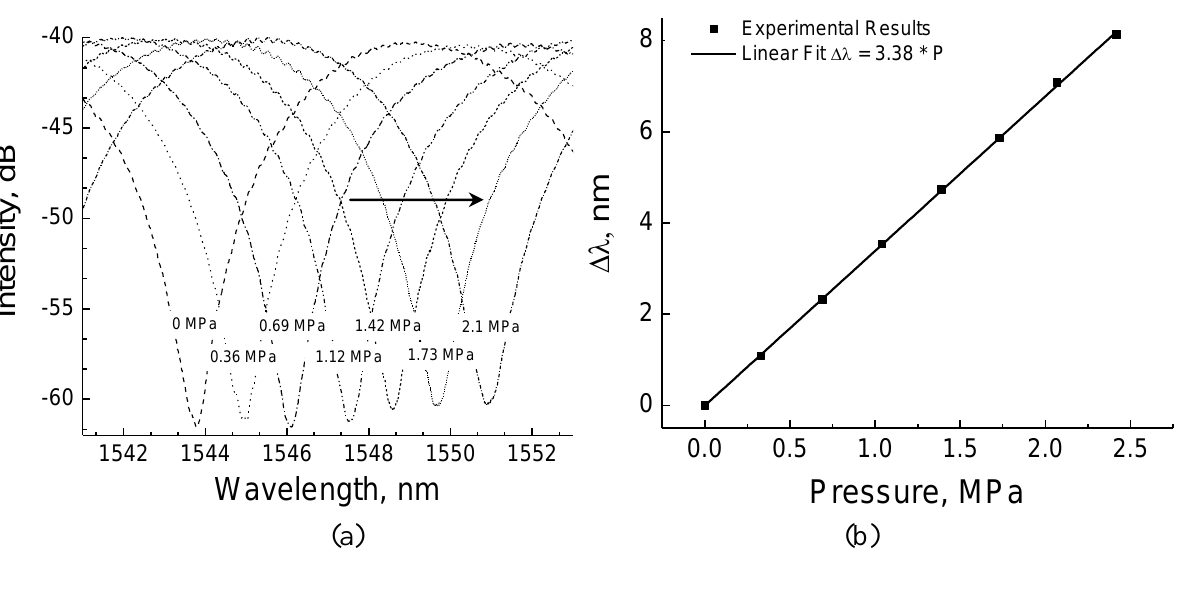
Figure 7. Temperature response (λ = 1,550 nm, L = 143